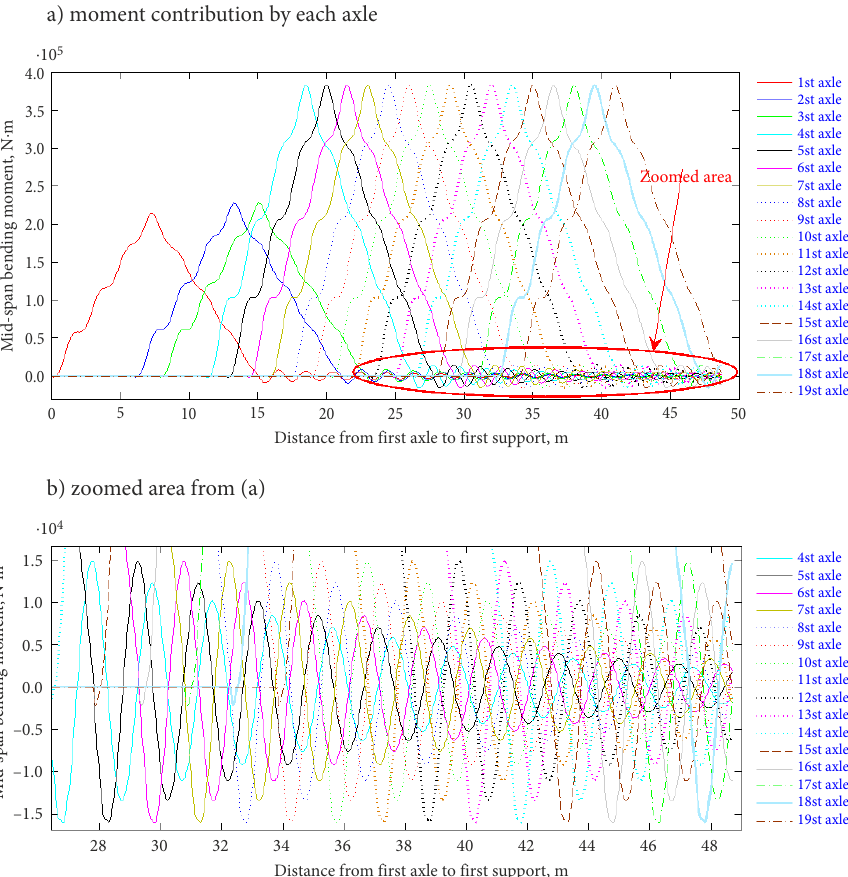
Figure 8. Individual contributions of each axle to total bending moment at 39.96 km/h